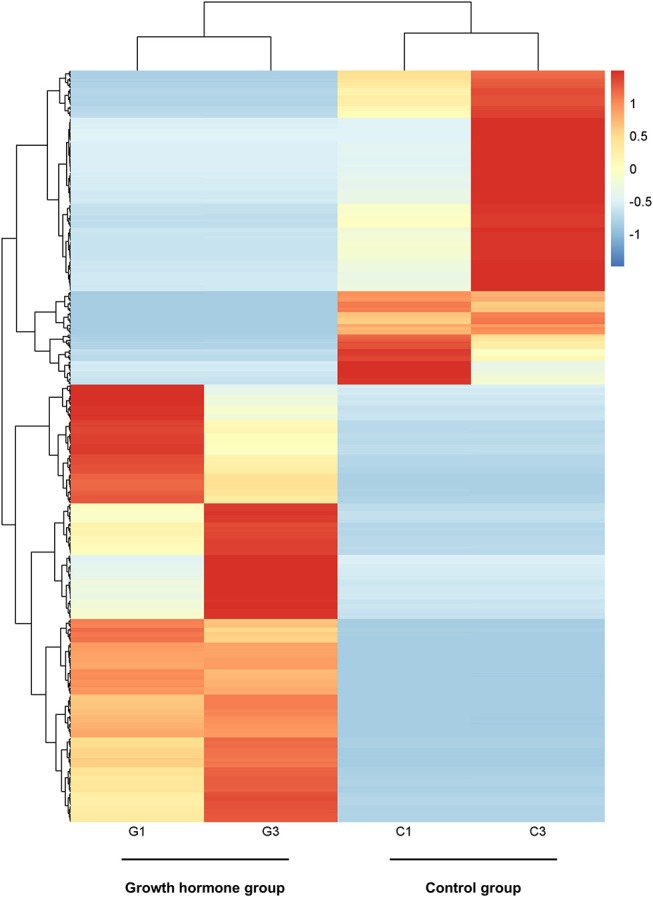
The heatmap of distinct gene expression profiles in GH cultured oocytes compared to the control group according to adjusted P-value < 0.05. Each row represents one gene expression levels among the four samples; Each column represents the expression levels of the genes in one sample; The black tree lines represent the results of layered clustering for the genes or samples, and the similar ones will be clustered. The different colors represent different expression levels and the illustration in the right represents the corresponding relationship between colors and the value of expression levels after standardization. G1and G3 represent samples from GH group; C1 and C3 represent samples from the control group.